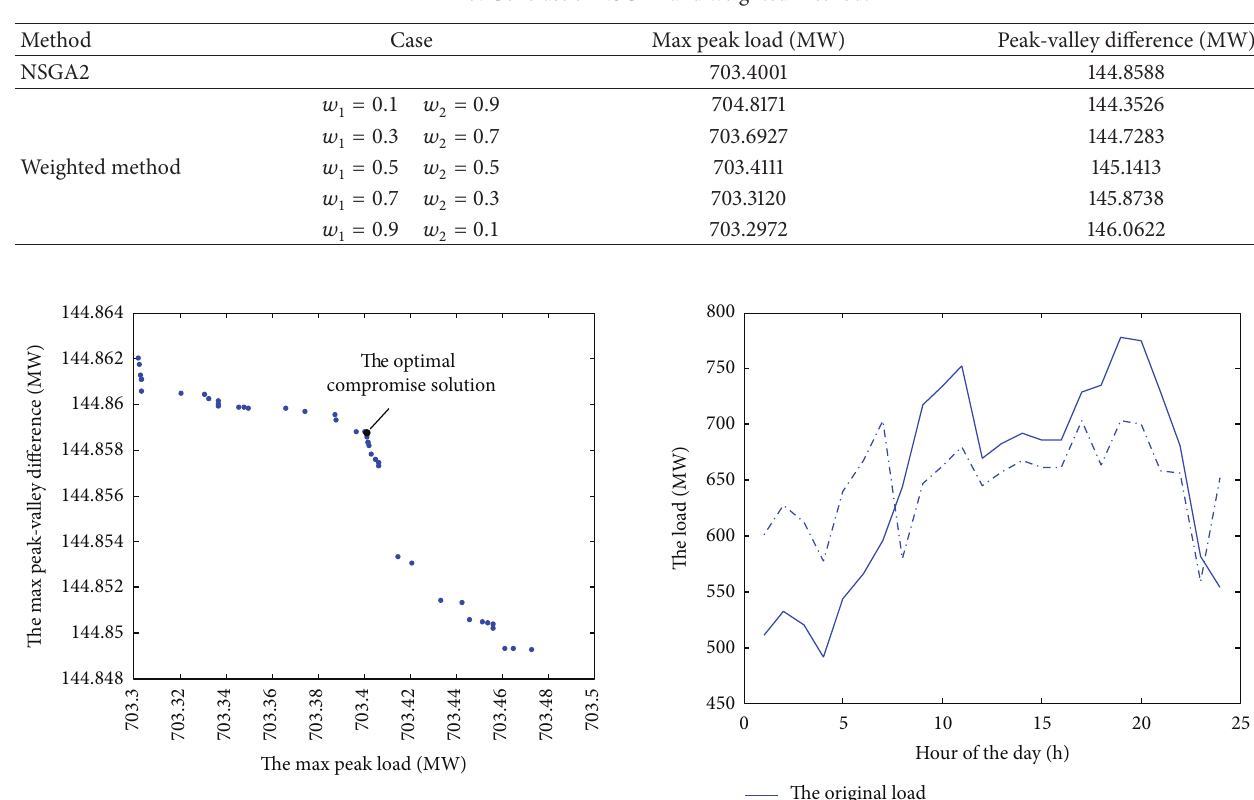
Figure 4: Pareto front.